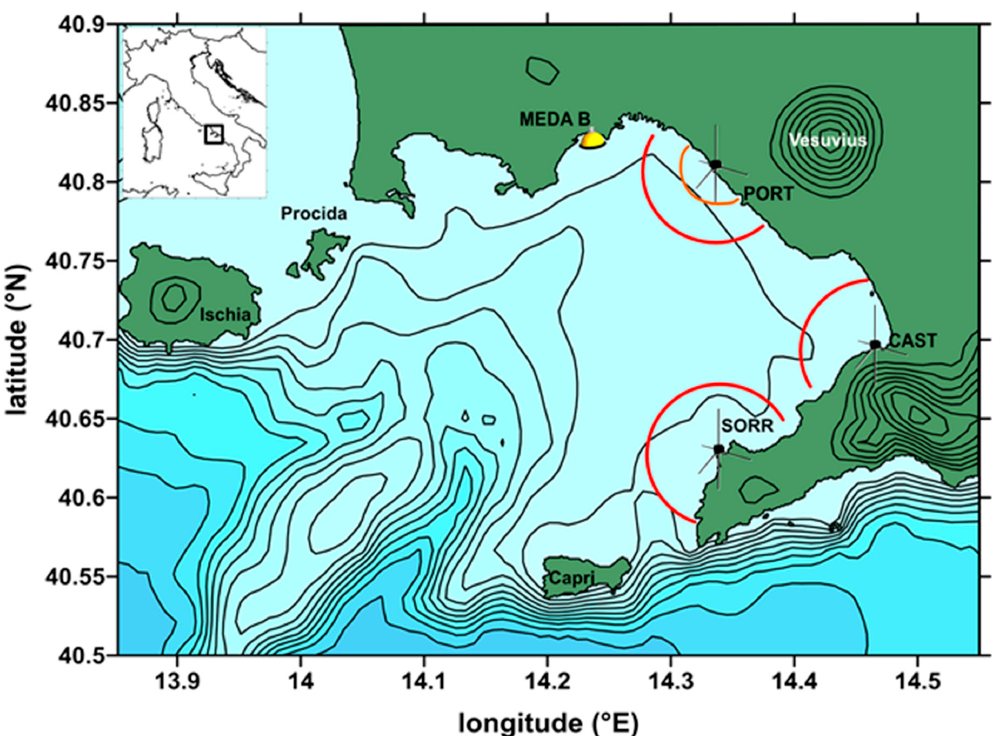
Figure 1. Map of the Gulf of Naples (south-eastern Tyrrhenian Sea, western Mediterranean Sea; see inset) with the locations of the three HF radar sites (antenna icons) and of ADCP connected to the MEDA B elastic beacon (buoy icon). The annuli centered on HF antennas represent RC5 (red) and RC2 (orange) (see text for details). The bathymetric and orographic contours were spaced every 100 m; elevation isolines were plotted starting from 300 m for graphical reasons.